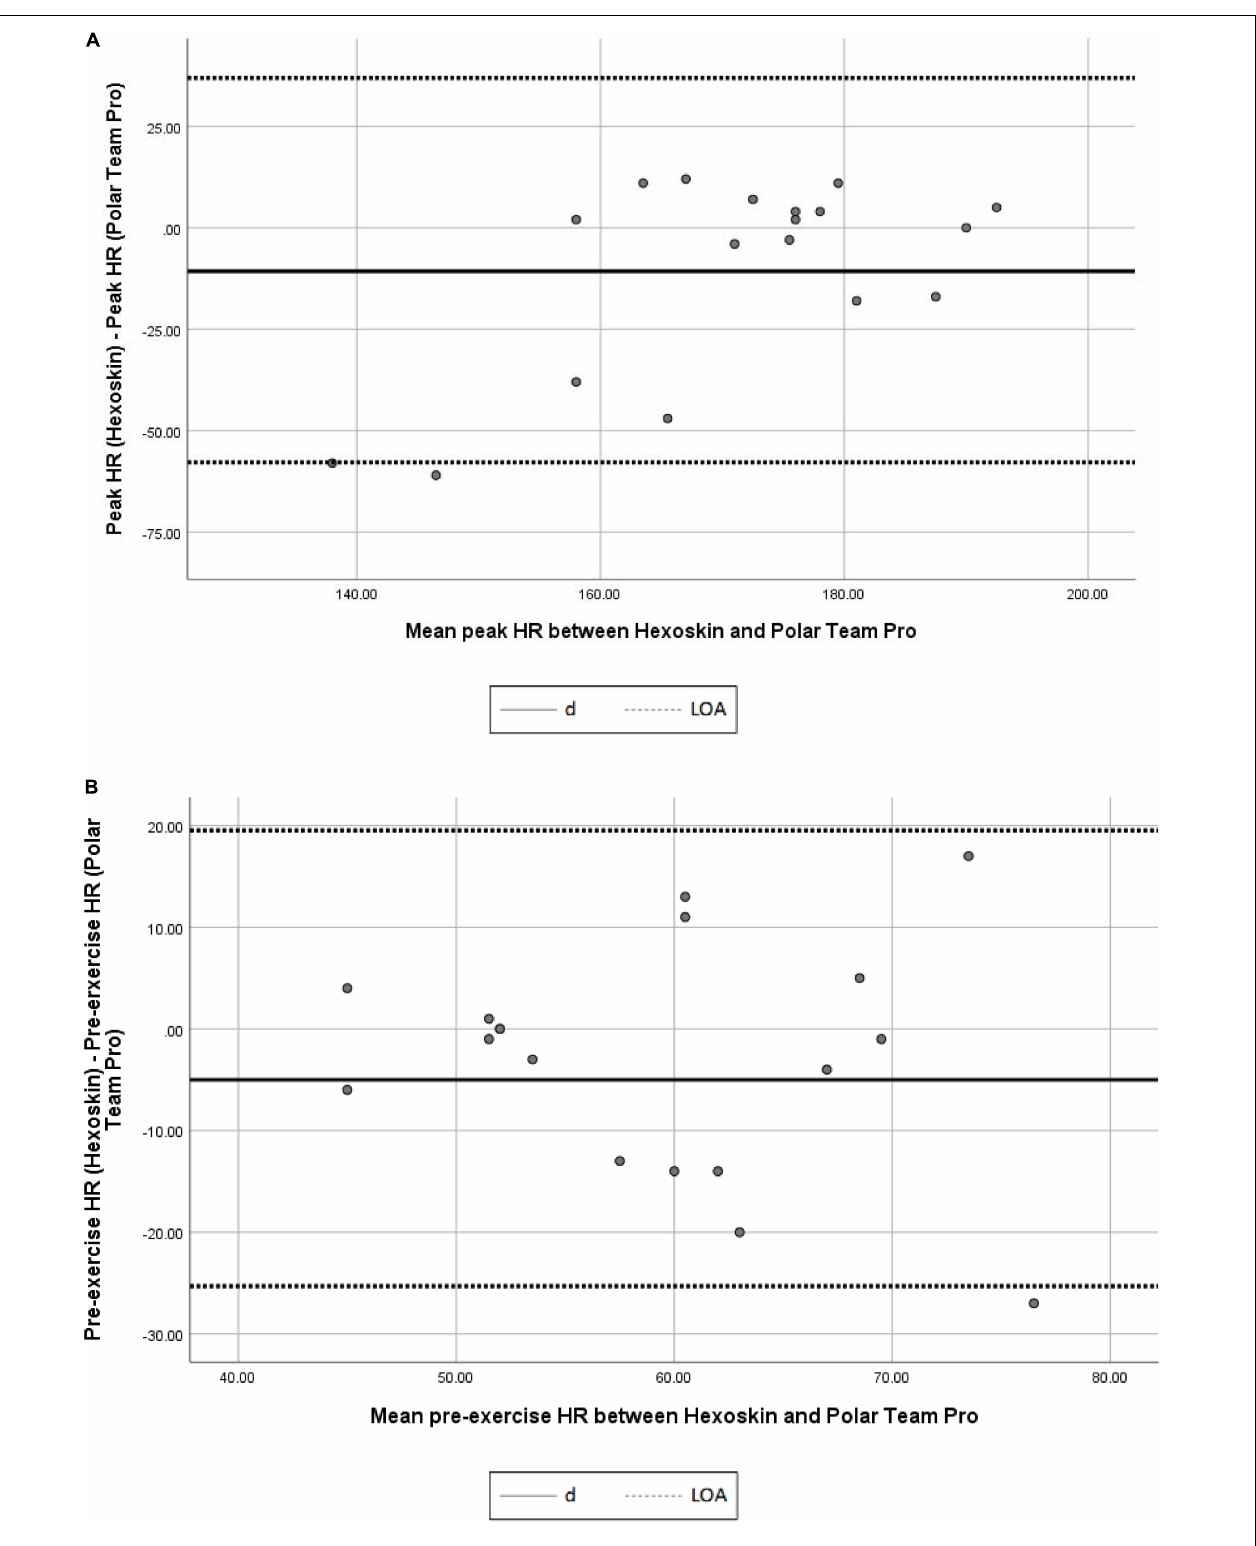
FIGURE 1 | (A) Bland and Altman plot concurrent validity of Hexoskin in measuring peak HR. d, mean difference between peak HR (Hexoskin) and peak HR (Polar Team Pro). LOA, limits of agreement; HR, heart rate (batt/min). (B) Bland and Altman plot validity of Hexoskin in measuring pre-exercise HR. d, mean difference between pre-exercise HR (Hexoskin) and pre-exercise HR (Polar Team Pro); LOA, limits of agreement; HR, heart rate (batt/min).